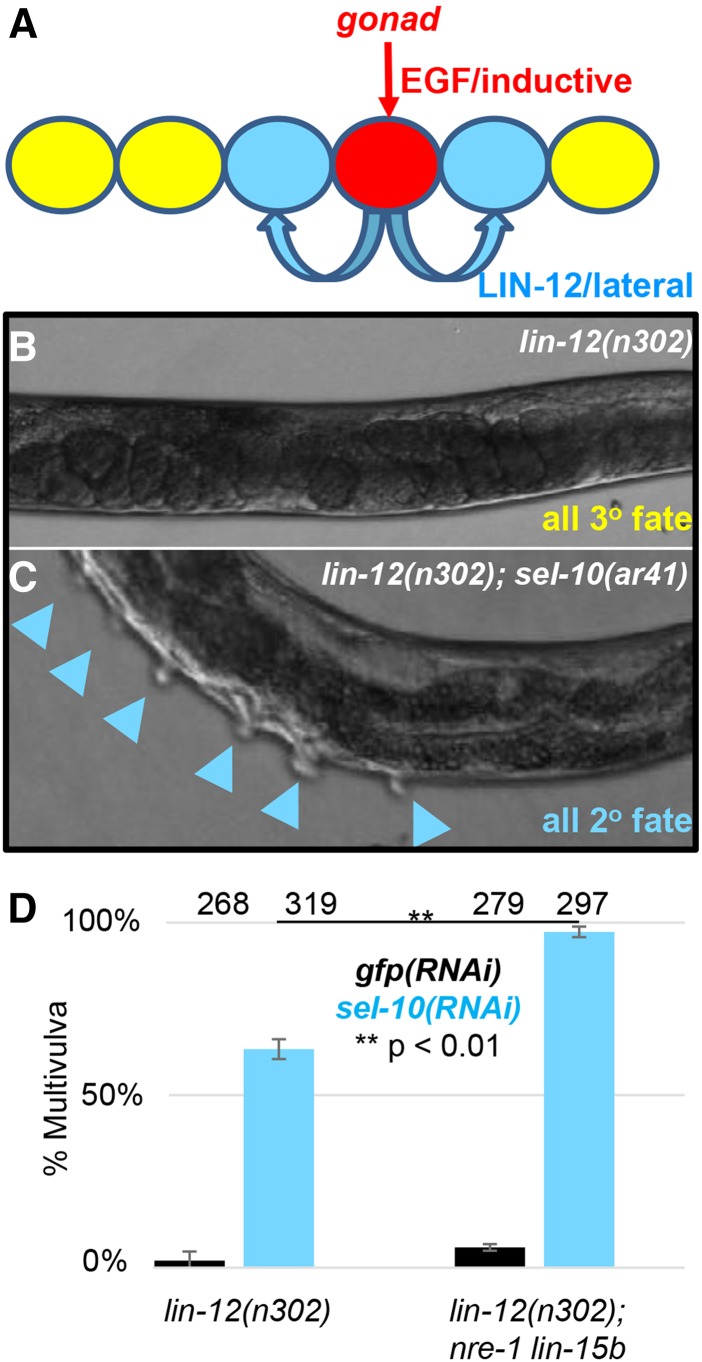
A simple phenotype-based RNAi screen for new negative regulators of LIN-12/Notch in C. elegans. A. Vulval Precursor Cell (VPC) fate patterning in the L3 stage of wild-type hermaphrodites. An EGF like inductive signal from the anchor cell (AC) of the gonad activates a canonical EGF like cascade in P6.p to specify the 1° vulval fate. The inductive signal also causes P6.p to express a lateral signal composed of ligands for LIN-12/Notch. The activation of LIN-12/Notch in P5.p and P7.p specifies the 2° vulval fate. B. lin-12(n302) hermaphrodites have a relatively mild degree of constitutive lin-12 activity. This level of activity is enough to prevent the specification of the AC, so the inductive signal is not produced; however, there is insufficient constitutive activity to cause ligand-independent specification of the VPC 2° fate (Greenwald et al., 1983; Levitan and Greenwald 1995). The VPCs therefore behave like wild-type VPCs that have not received inductive signal, and all adopt the 3° fate (Sternberg 2005). C. Enhancement of lin-12(n302) by loss of sel-10. Loss of a negative regulator, such as seen using a null allele of sel-10/Fbw7, leads to an increase in the level of lin-12(n302) activity, so that all VPCs can adopt the 2° fate even in the absence of an AC (Greenwald et al., 1983; Sundaram and Greenwald 1993; Hubbard et al. 1997). D. Basis for the kinome RNAi screen. sel-10(RNAi) enhances lin-12(n302) activity, and the effectiveness of sel-10(RNAi) is improved by the inclusion of nre-1(hd20) lin-15b(hd126) to increase sensitivity to RNAi (Schmitz et al. 2007).